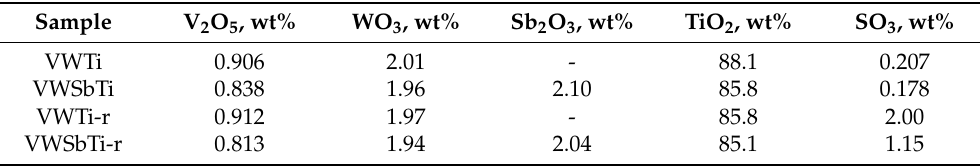
Table 1. XRF measurements of the samples.